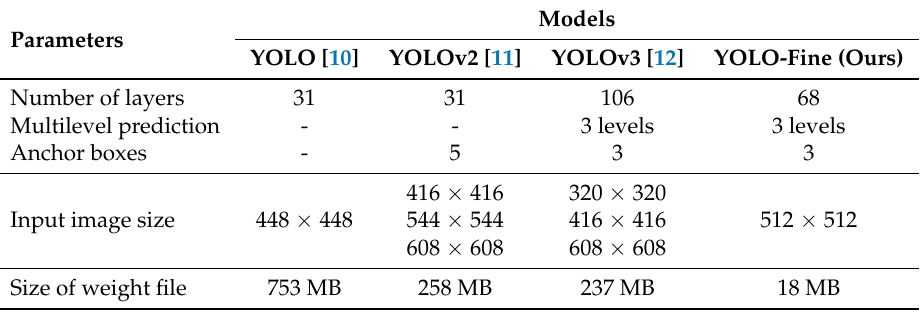
Table 1. Comparison of the three YOLO versions and our YOLO-fine model in terms of architecture parameters. We note that the reported input image size of each model was the one originally proposed by the authors. In our experiments, we set all to 512 (cf. Section